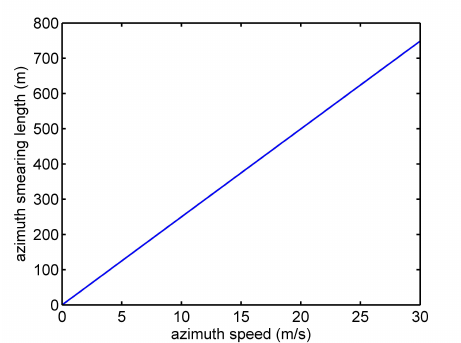
Figure 5. The target’s azimuth smearing length in 12.5 s (Gaofen-3 illuminating time in staring spotlight mode) versus azimuth